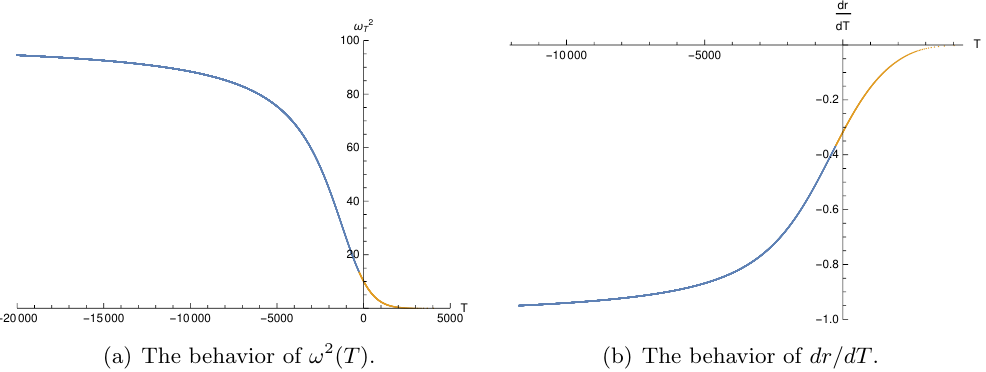
Figure 2 . The behavior of (a) ! 2 ( T ) and (b) dr=dT for the choice of parameters: (cid:11) 0 = 1, n = 10 5 , r 0 = 500, R c = 499, C = 300, (cid:1) t = 10, b = 5, R = 2 (cid:2) 10 4 . The blue segment corresponds to the region outside the horizon region while the orange segment corresponds to the region inside the